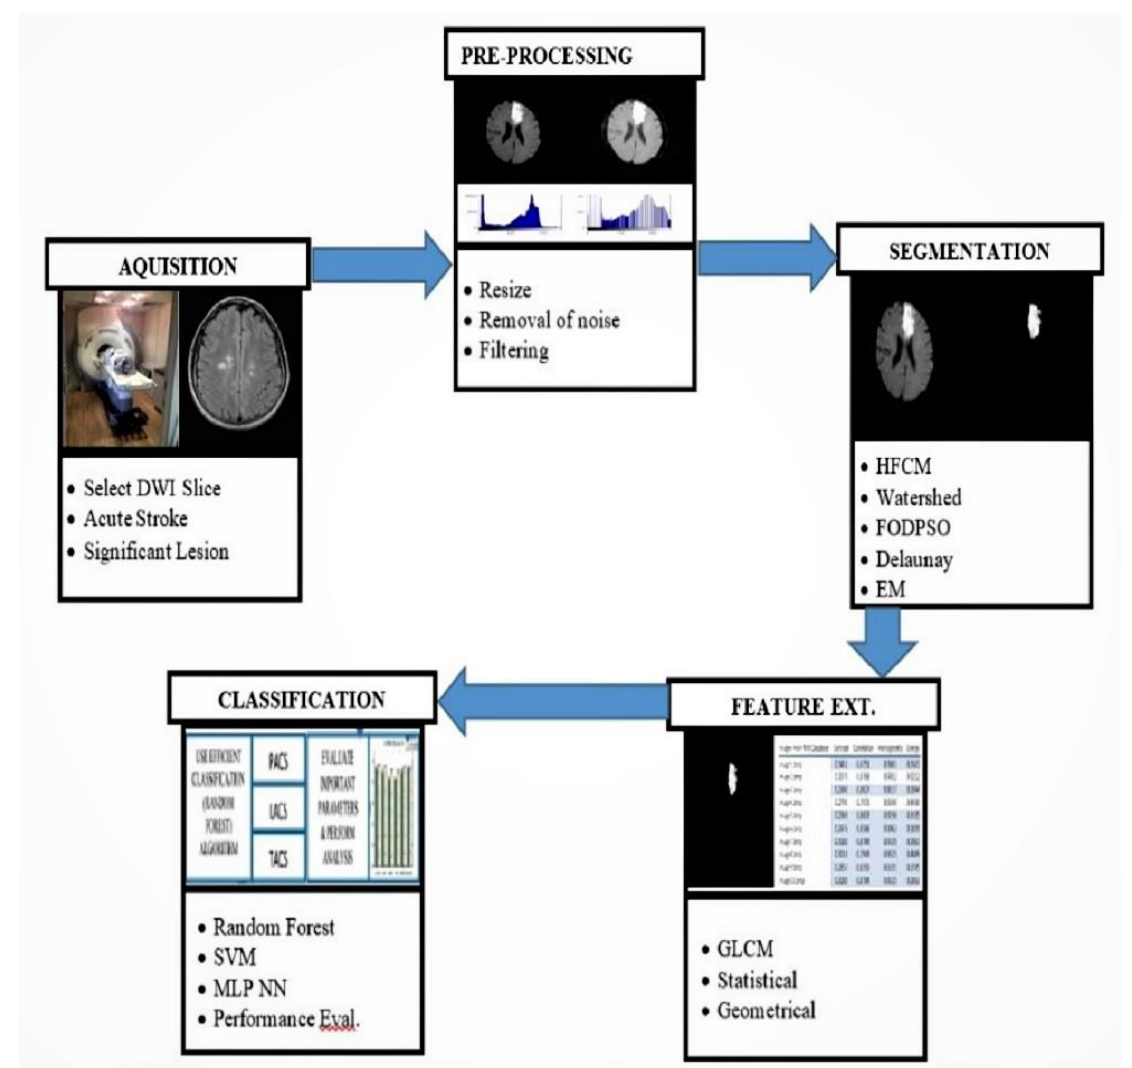
Figure 2. Flowchart of typical computed-aided diagnosis system for end-to-end stroke detection. DNN, deep neural network; NN, neural network.